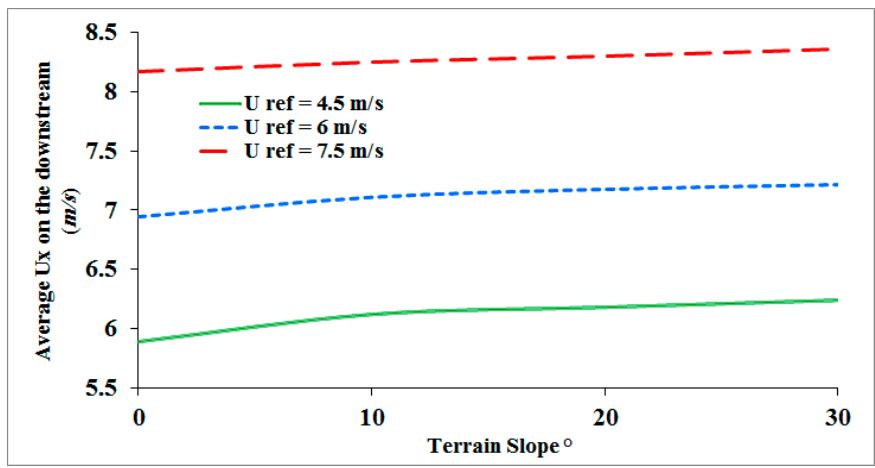
Figure 7. Average Ux on the downstream for U ref = 4.5, 6, and 7.5 m/s and terrain slope 0 ◦ , 10 ◦ , 20 ◦ , and 30 ◦